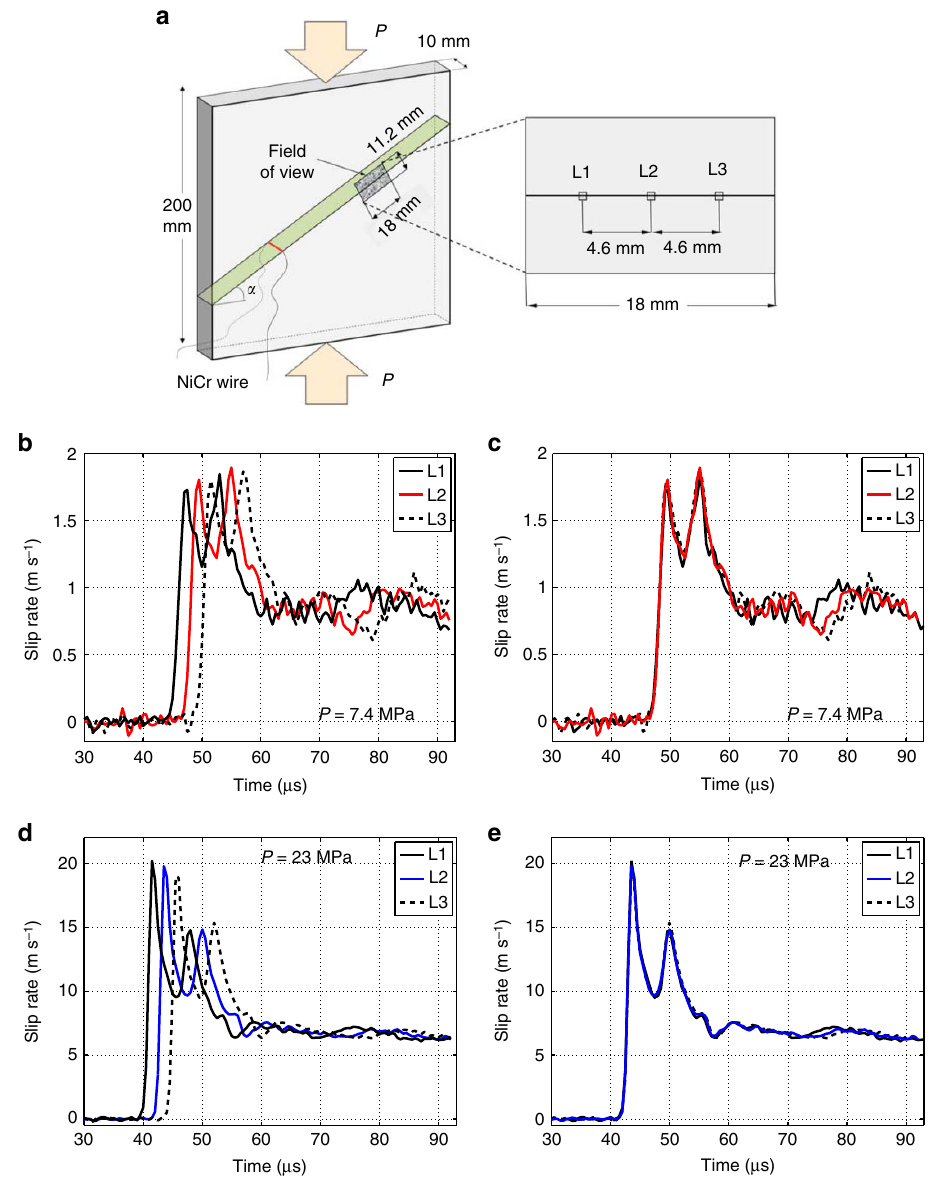
Figure 7 | Steady propagation of spontaneously evolving ruptures. ( a ) Sketch of the specimen configuration showing the field of view and the locations corresponding to the slip-rate curves. ( b – d ) Slip-rate time histories (averaged over 1mm) obtained at the three selected locations along the interface, for P ¼ 7.4MPa ( b ) and P ¼ 23MPa ( d ) respectively. ( c – e ) The time histories at locations L1 and L3 are time shifted (respectively, forward and backward) by D t ¼ d / V r , where d is the distance between L1 and L2 (and also L2 and L3) and V r is the rupture speed. The near-perfect overlap of the shifted time histories at locations L1 and L3 with the time history at L2 shows that the ruptures are well developed and propagate in a steady fashion through our field of